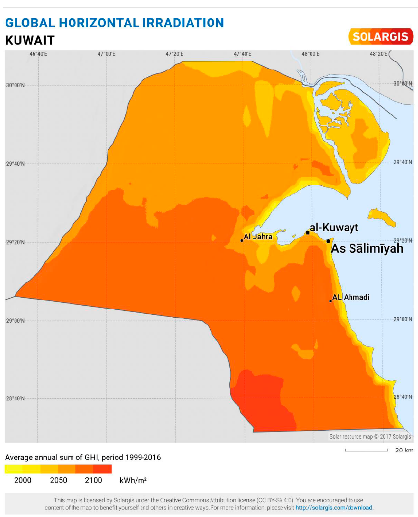
Figure 4. Horizontal irradiation distribution in Kuwait.